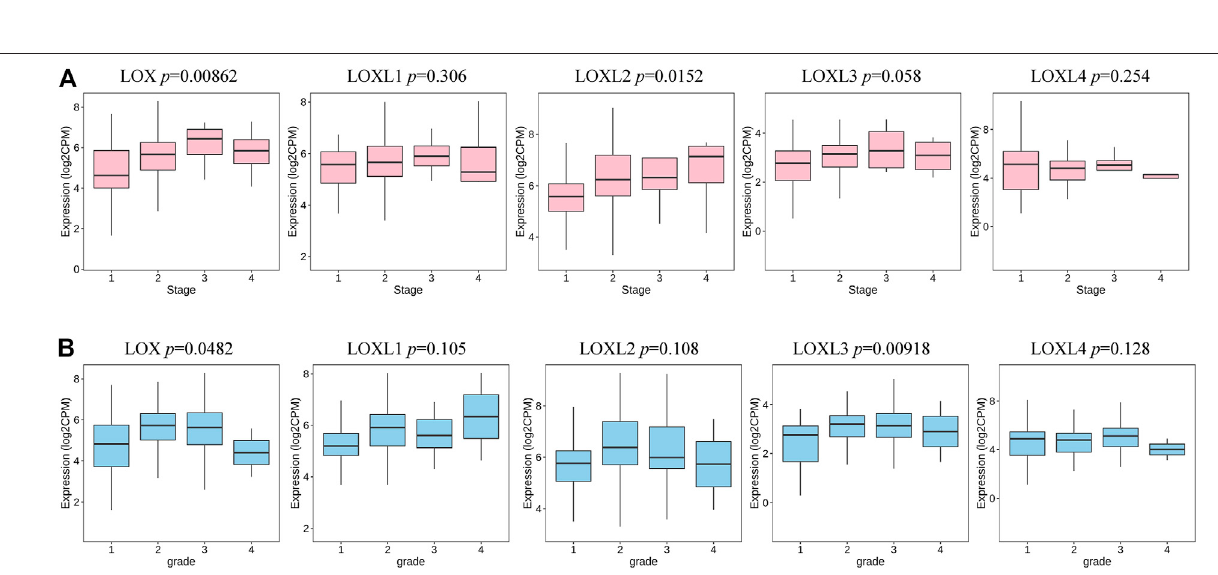
Frontiers in Molecular Biosciences |